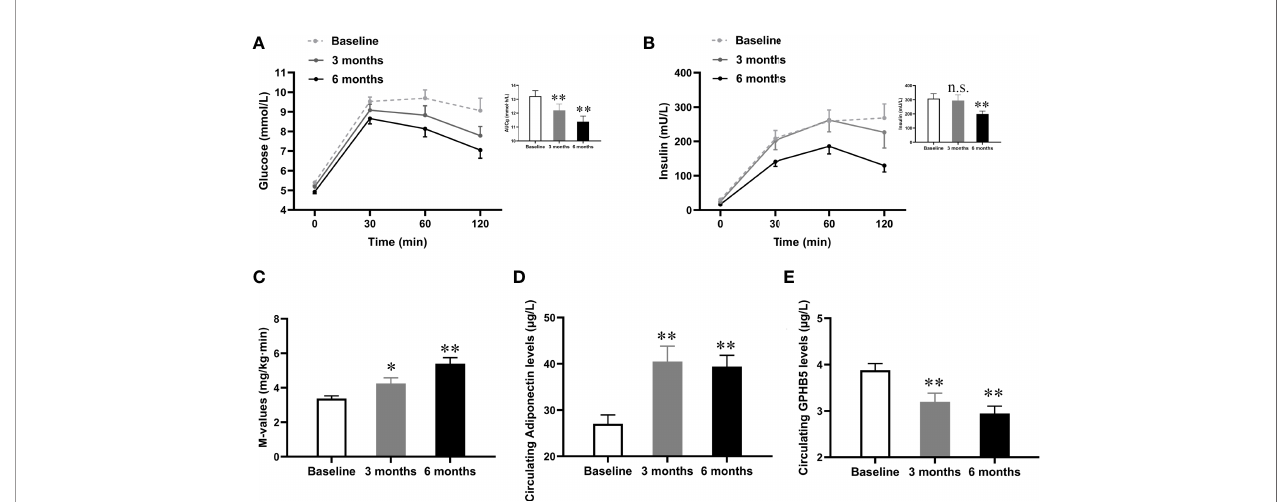
FIGURE 6 | Effects of GLP-1RA treatment on serum GPHB5 levels and insulin sensitivity in MetS women. (A) Blood glucose levels and AUCg during the OGTT at pre- and post-treatment. (B) Insulin levels and AUCi during the OGTT at pre- and post-treatment. (C) M-values during the EHC at pre- and post-treatment. (D) Serum adiponectin levels at pre- and post-treatment. (E) Serum GPHB5 levels at pre- and post-treatment. AUC, area under the curve during oral glucose tolerance. Data are means ± SD. * p < 0.05 or ** p < 0.01 as compared with Baseline. n.s., no signi fi cance; p > 0.05 vs.